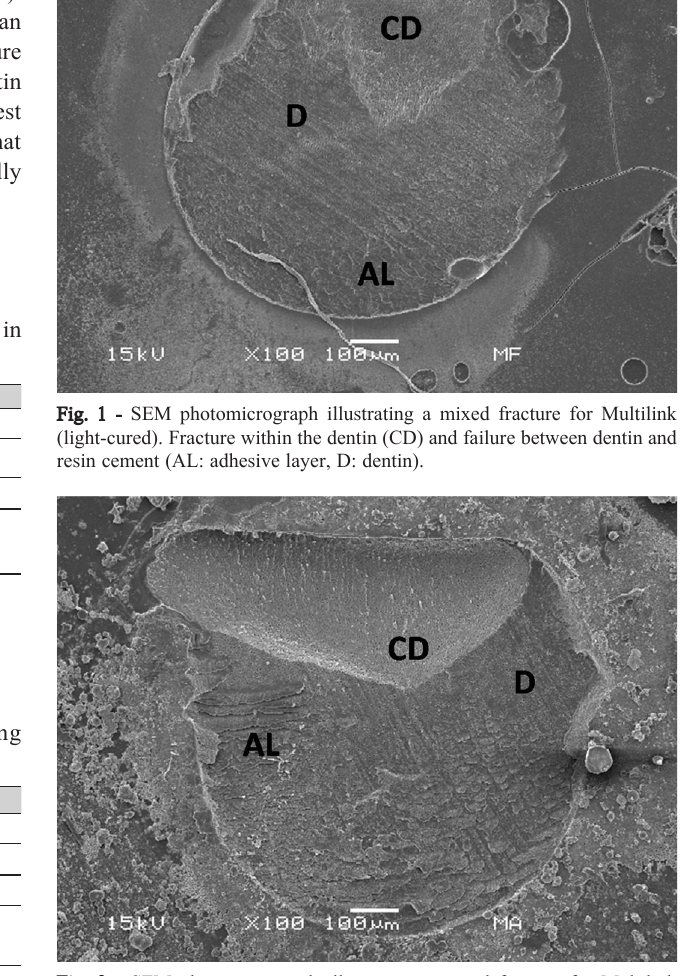
Fig. 2 - SEM photomicrograph illustrating a mixed fracture for Multilink (self-cured). Fracture within the dentin (CD) and failure between dentin and resin cement (AL: adhesive layer, D: dentin).